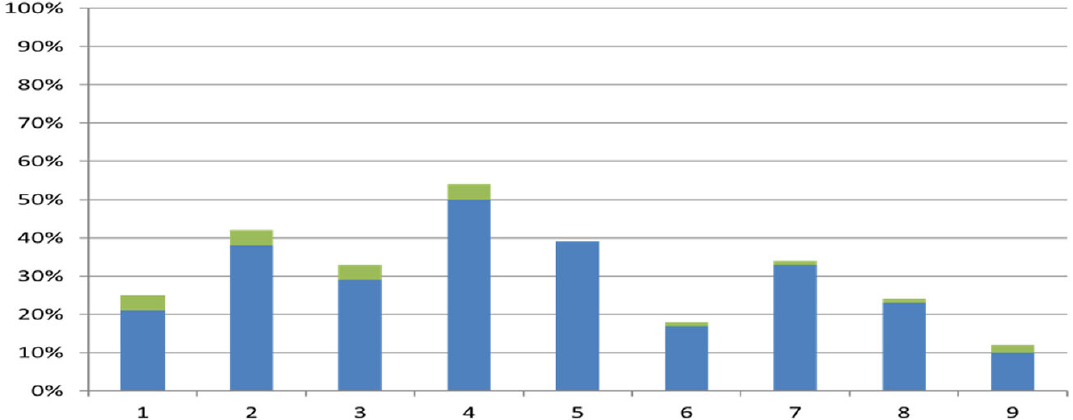
Figure 4. Expert assessment of scientific potential growth as the basic precedent for parameters of the neural network.